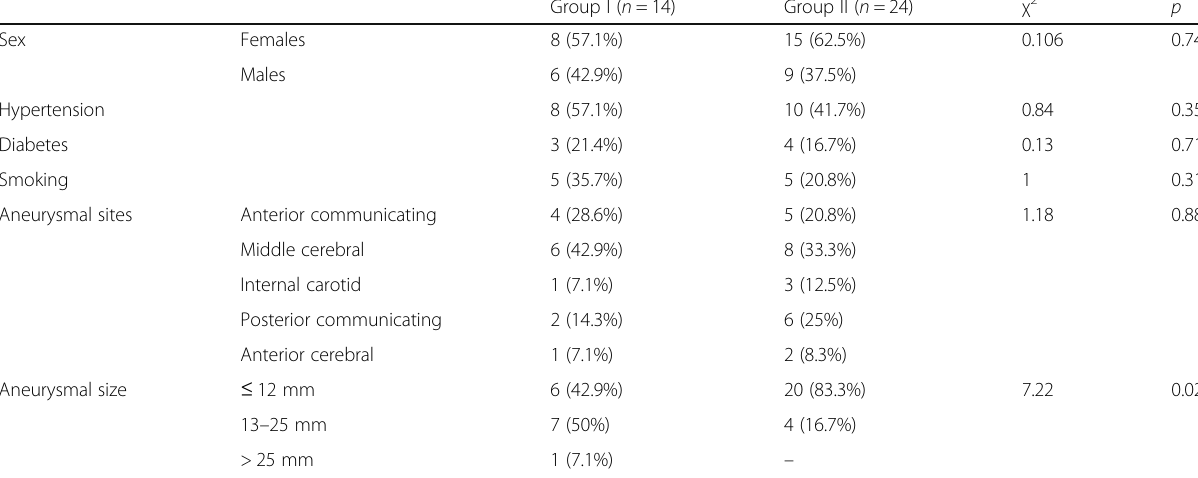
Table 1 Demographic data, aneurysmal sites and sizes among patients developed cerebral vasospasm (group I), and those did not develop vasospasm (group